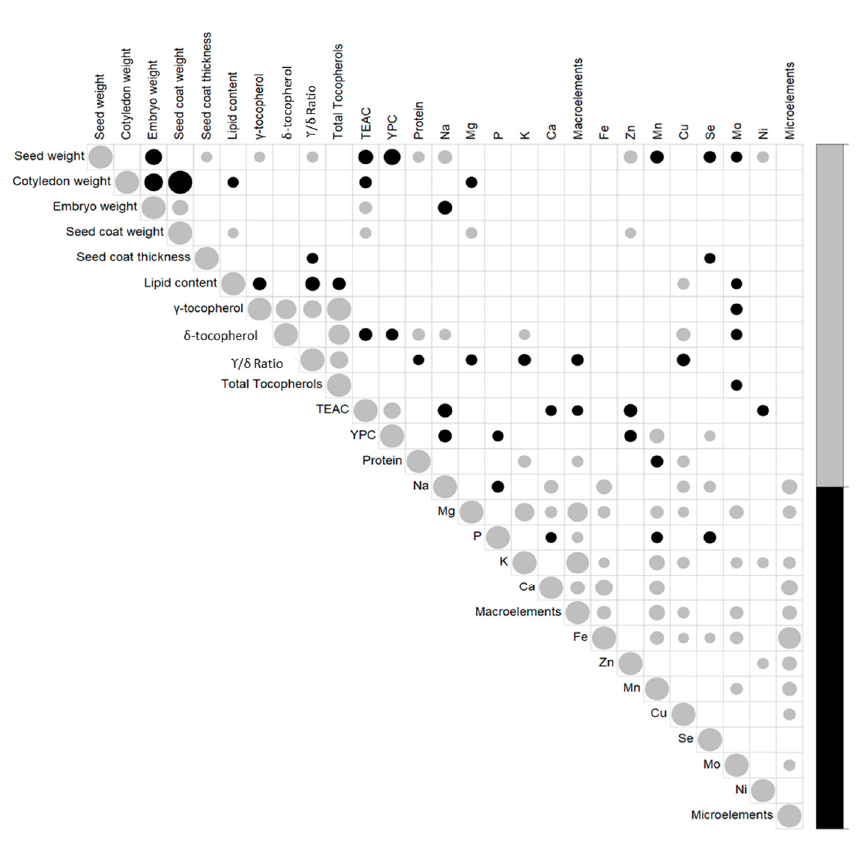
Figure 7. Correlation plot matrix between the traits for the 25 American and European accessions. Only significant correlations are shown ( p < 0.05). The size of the symbols indicates the value of each correlation. Black, negative correlations; gray, positive correlations (for details, see Table S4). All of the significant correlations between the different macro-elements and micro- elements were positive, except for the macro-element P, which was negatively correlated with Na, Ca, Mn, and Se (r = − 0.26, − 0.21, − 0.23, − 0.27, respectively; p < 0.05). Among the macro-elements and micro-elements, the positive correlations that showed significance ( p < 0.001) were those between Ca and Na (r = 0.34), Mn and K (r = 0.43), Mn and Ca (r = 0.41), Mg and Mo (r = 0.34), Mg and K (r = 0.64), and Fe with Ca (r = 0.52), Na (r = 0.42) and Mn (r = 0.33). K and Mg were strongly correlated with the total amount of macro- elements (r = 0.88, 0.70, respectively, p < 0.001), and Fe content with the total micro-elements content (r = 0.88, p <